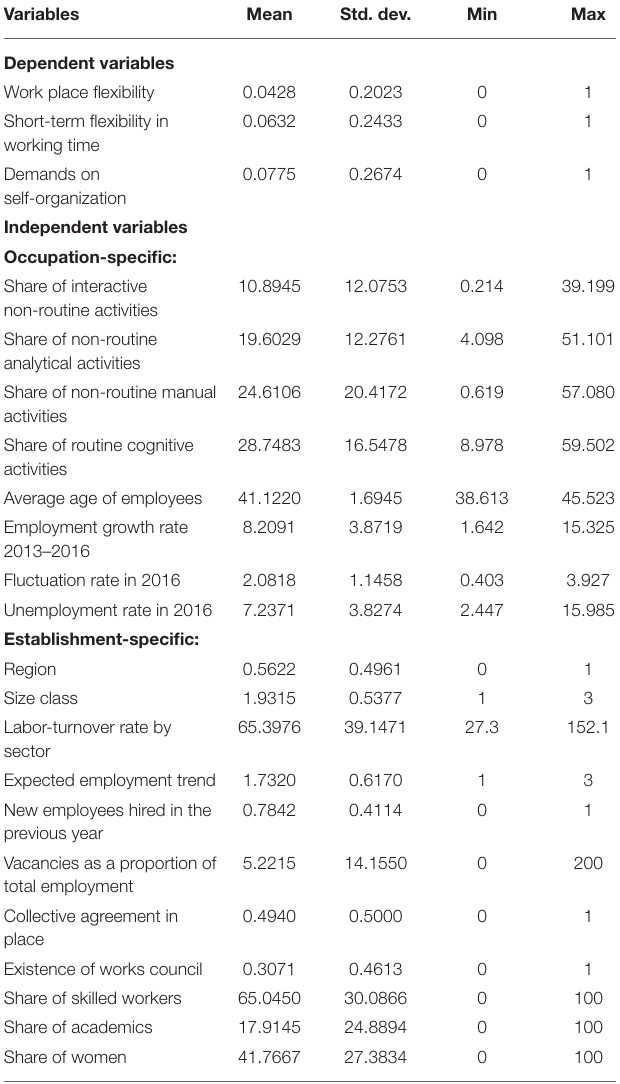
TABLE 2 | Descriptives of the variables used in the estimation